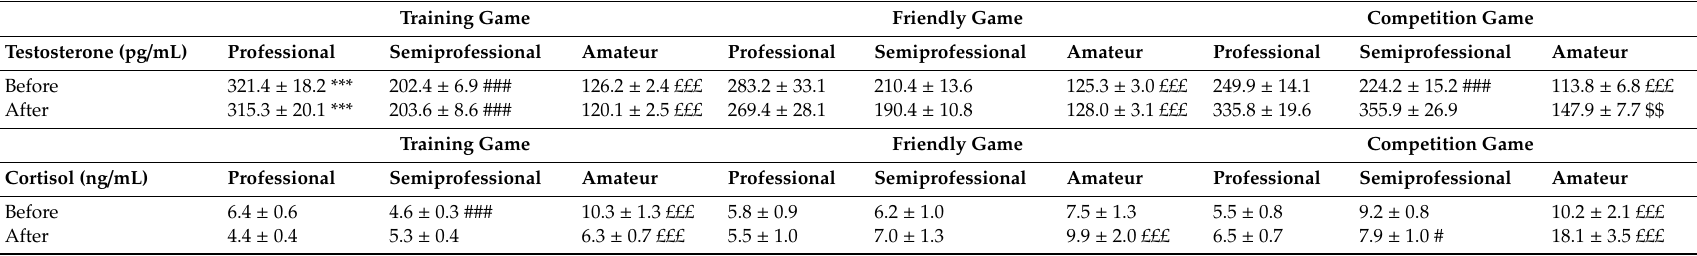
Table 1. Salivary testosterone and cortisol concentrations before and after the training, friendly game and o ffi cial games in professional ( n = 39), semiprofessional ( n = 27) and amateur ( n = 29) soccer players (mean ± standard error of